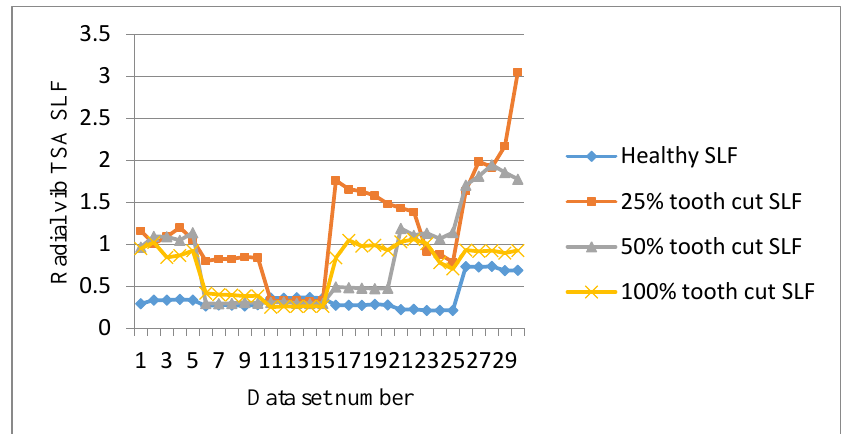
Figure 18. SLF of radial vibration TSA